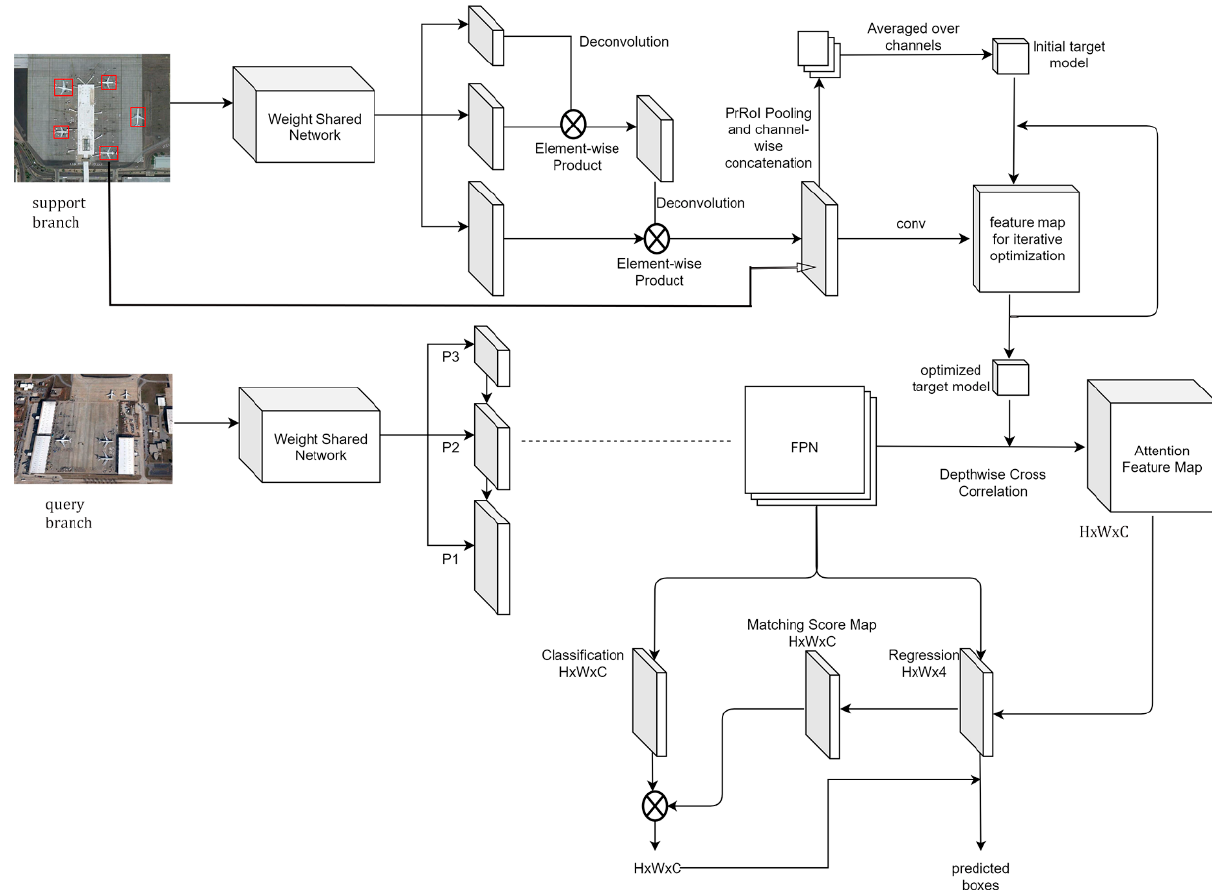
Figure 1. Network overall architecture. The feature maps of the support image are combined by deconvolution and element-wise product while that of support image are reserved to form FPN. The combined feature map of support is used to extract the initial target model and iteratively optimize the target model. The final target model is utilized to compute the similarity map with the feature maps from the query set as the attention feature map H × W × C, which helps our model match the categories in support from the regression results. For simplicity, only one support branch is shown. C represents the number of novel categories to be detected, that is, the number of support branches. After performing the depth-wise cross correlation between the final target model of each support branch and the feature map obtained from the query branch, an attention feature map of H × W × 1 is obtained. Additionally, after conducting channel-wise concatenation on these attention feature maps, a final attention feature map of H × W × C is obtained. The attention feature map is then utilized to get the matching score map H × W × C, which indicates the probability of each pixel in the regression bounding boxes belonging to the category in support by calculating the average probability of the pixels belonging to each category within the regression boxes. The first result of classification H × W × C is obtained by repeating a map of H × W × 1, which indicates the probability of the pixel belonging to a foreground on the channel C times. The final result of classification which indicates the probability of each pixel belonging to each category is obtained by conducting element-wise product between the first result of classification and the matching score map. Afterwards, this final result of classification map is utilized in turn to calculate the score of each regression bounding box on each category for